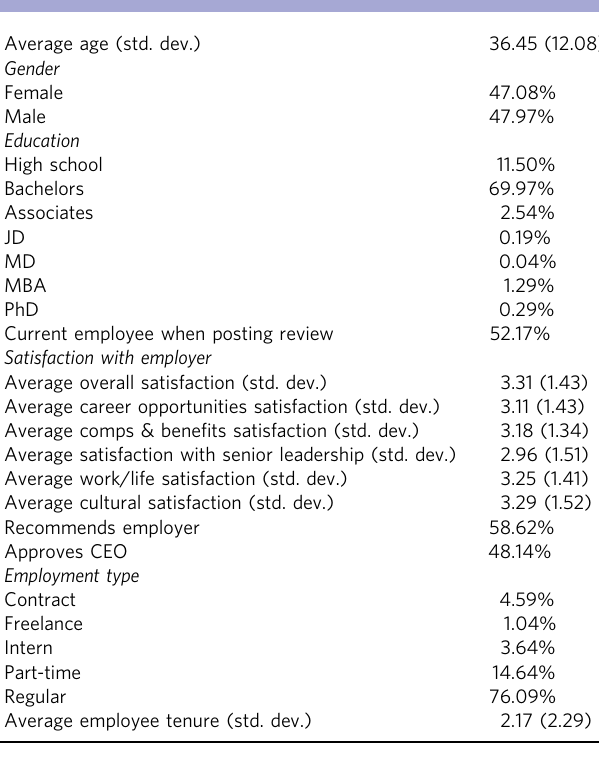
Average overall satisfaction (std.